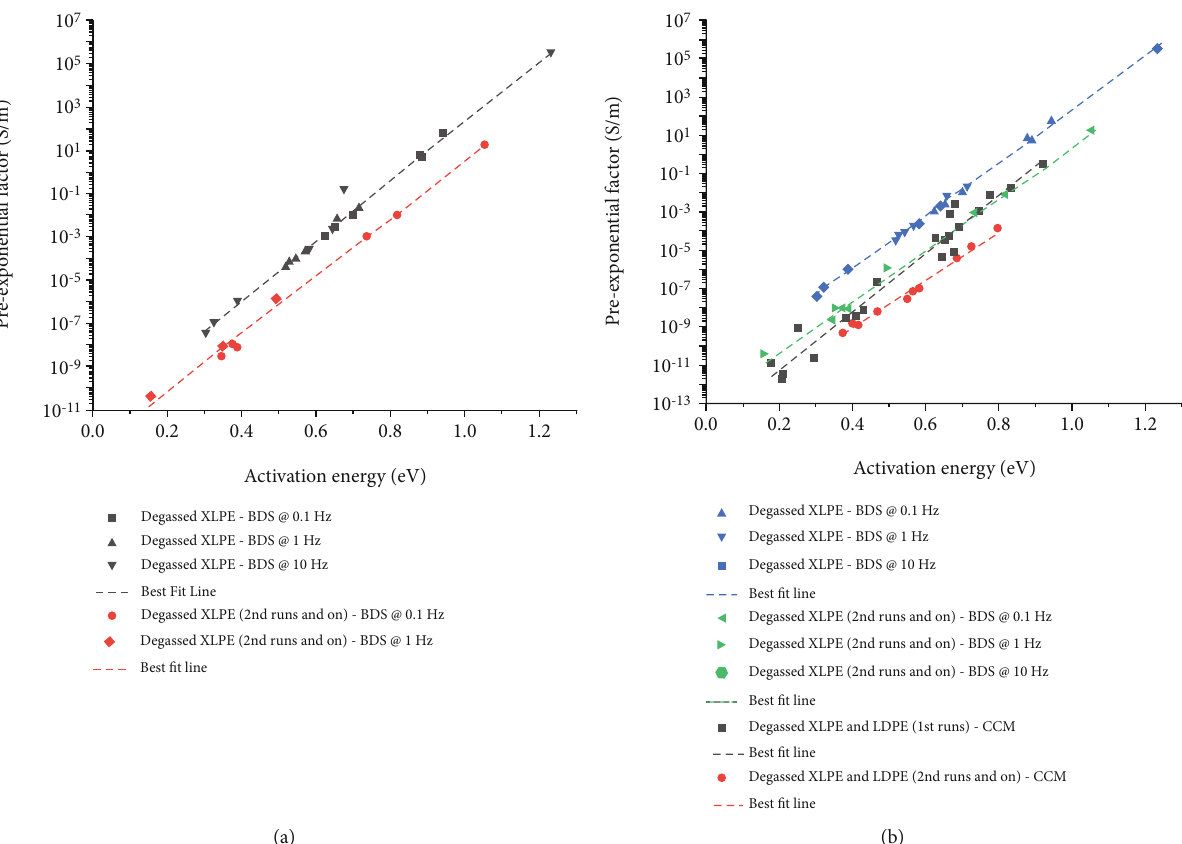
Figure 10: (a) Compensation plot of degassed XLPE samples repeatedly measured under AC conditions and comparison to the samples presented in Figure 4. (b) Combination of AC and DC data showing the changes in the compensation plot due to the annealing that occurs with repeat measurement or